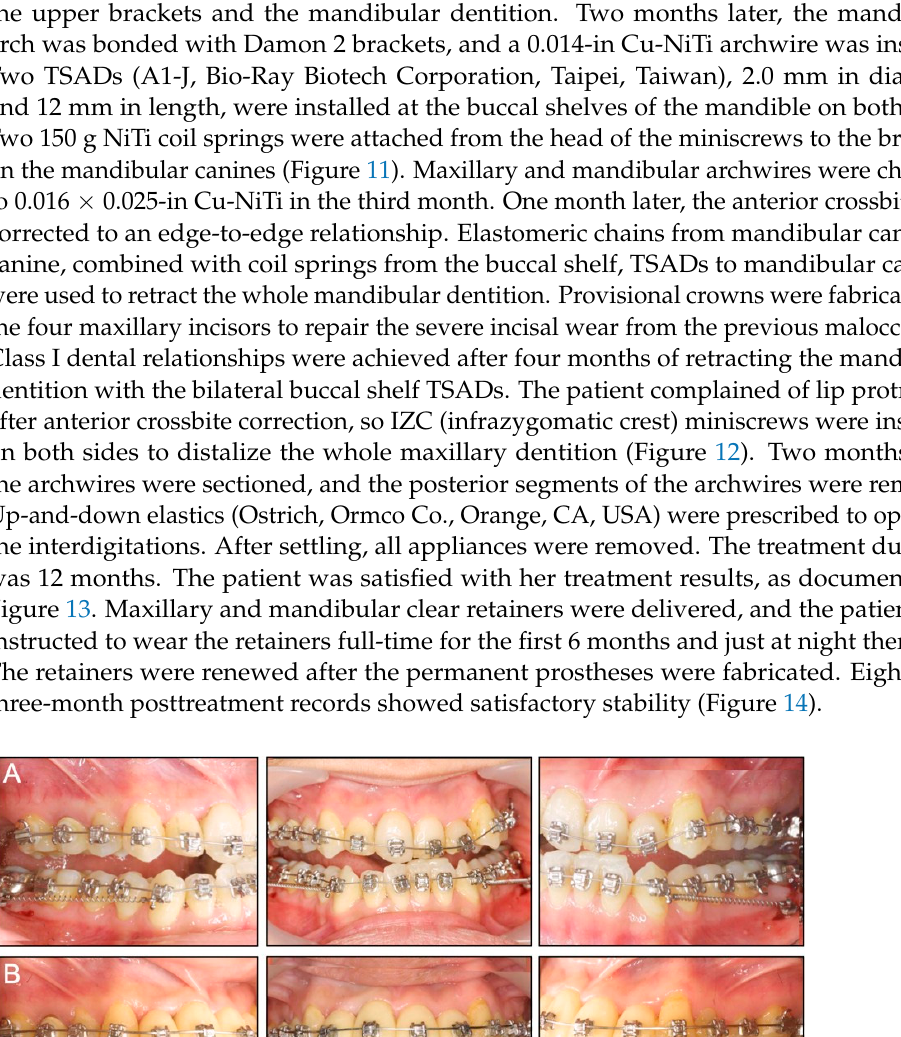
Figure 12. Case 2, Two upper posterior miniscrews were installed in the eighth month for the protrusion after the correction of anterior crossbite.